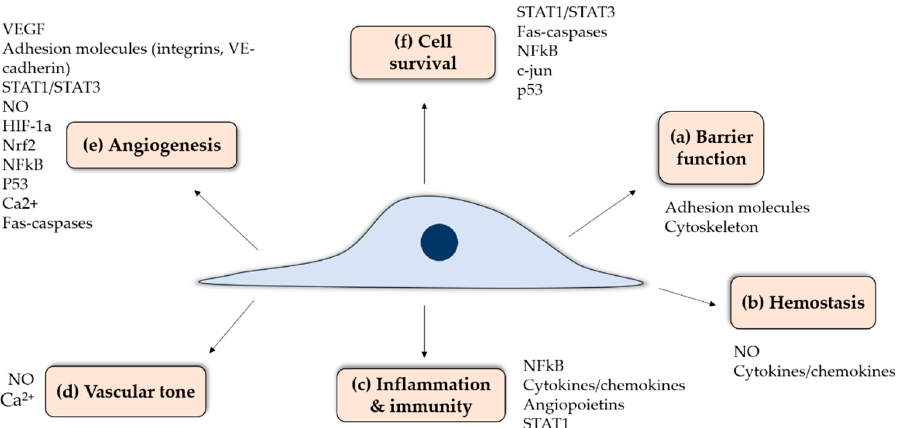
Figure 2. Schematic representation of the main endothelial cell functions and associated molecular pathways which are suspectable to S-glutathionylation.